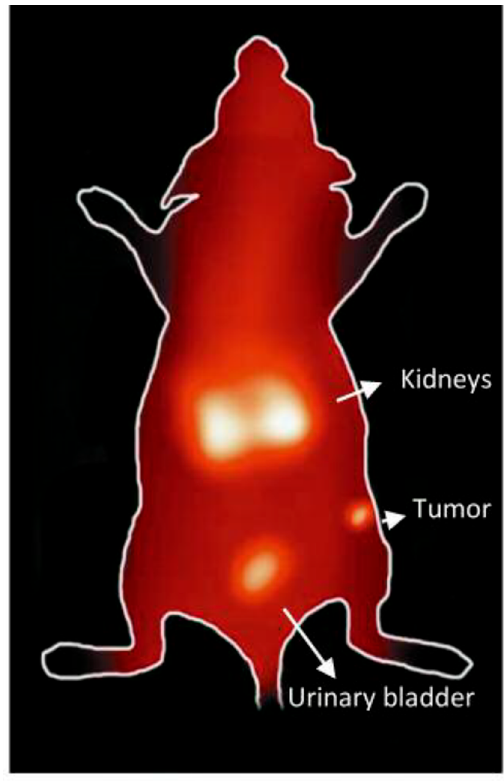
Figure 10. GammacamerafullbodyimageofnudemouseimplantedwithHER2-positive. SKBR3xenografts Figure 10. Gamma camera full body image of nude mouse implanted with HER2-positive. SKBR3 at 1 h post-injection of 99m Tc-HER2 xenografts at 1 h post-injection of 99m Tc-HER2 peptide.